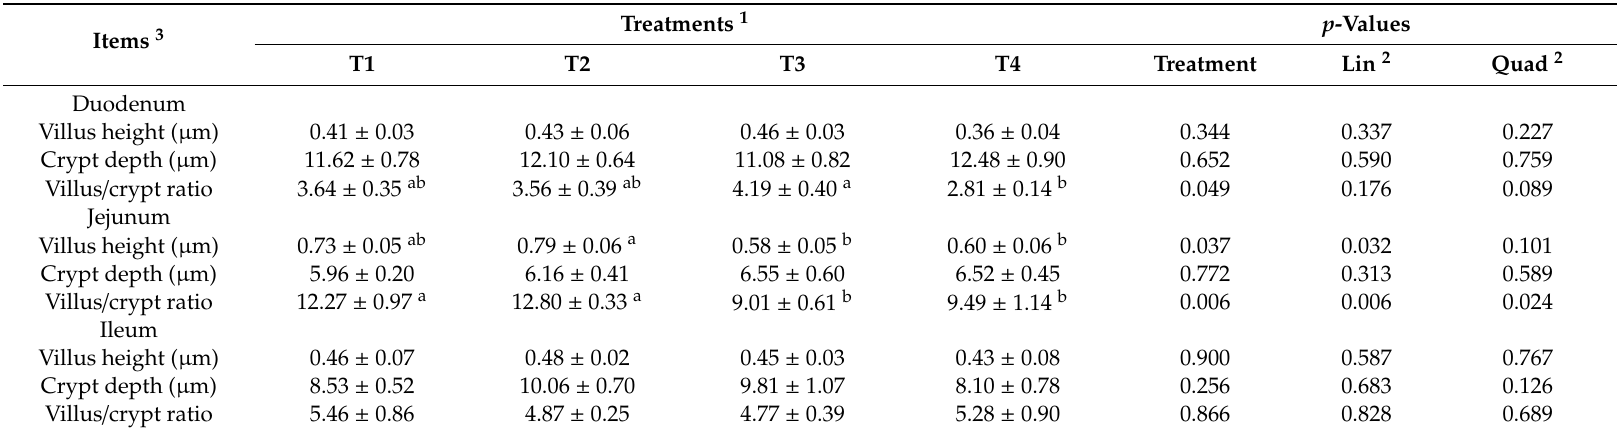
Table 8. E ff ects of the ratio of insoluble to soluble fiber in sow gestation diets on the morphometric measurements in the duodenum, jejunum, and ileum in neonatal